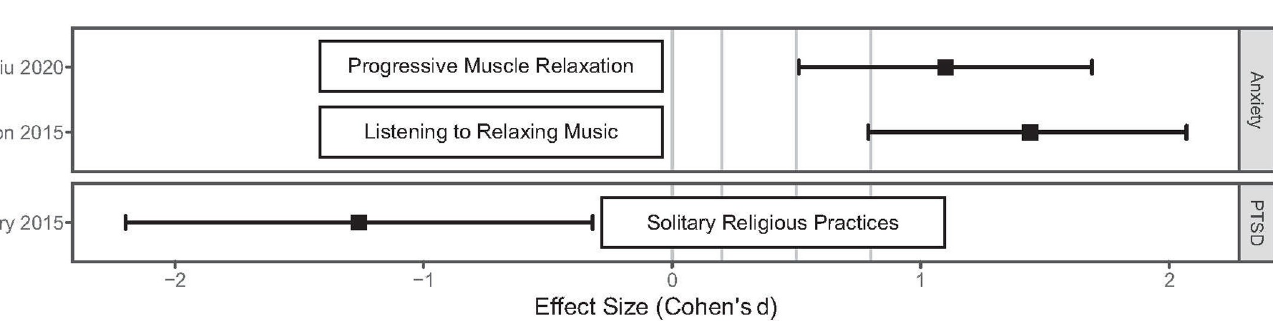
Fig 6. Effect size estimates for the impact of other activities on mental